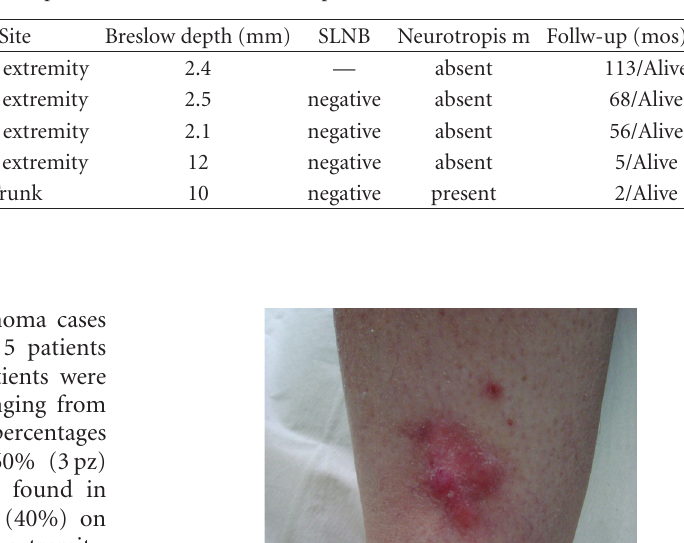
Table 1: Clinical features of 5 patients with cutaneous desmoplastic melanoma.